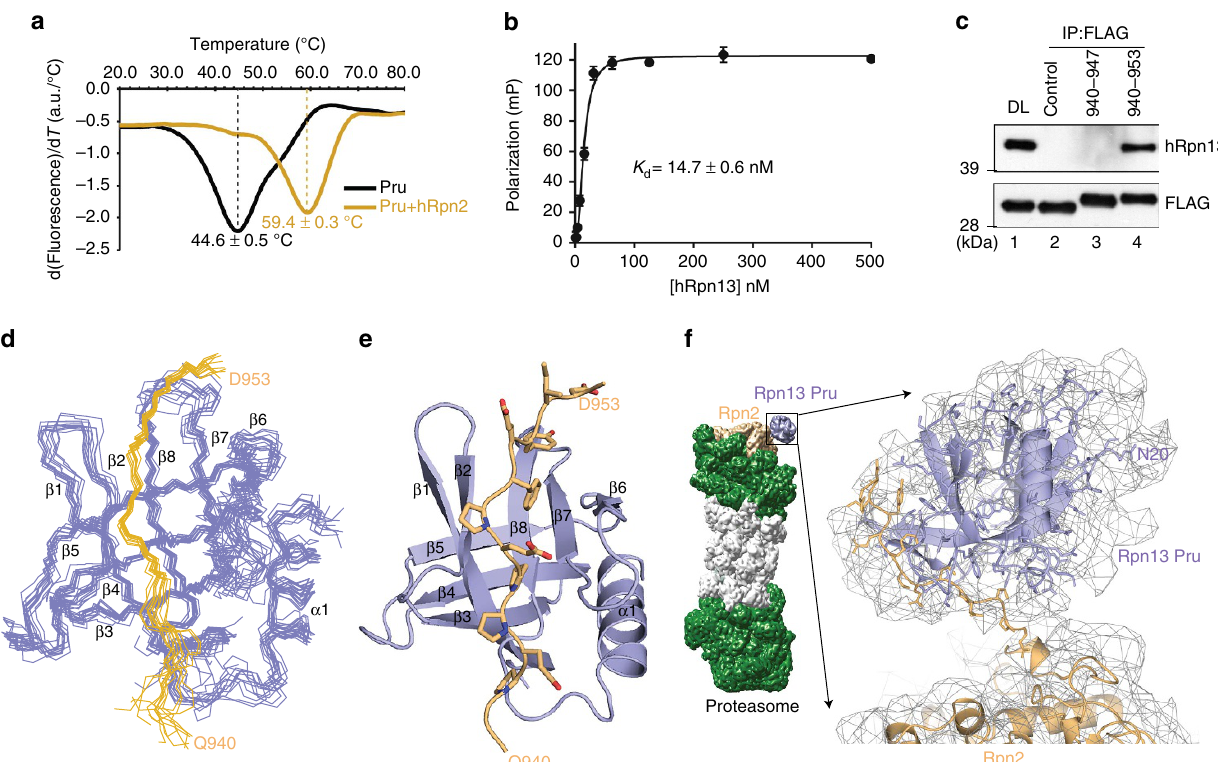
Figure 1 | Structure of hRpn13 at the proteasome. ( a ) hRpn13 Pru alone (black) or with hRpn2 (940–953) (orange) was heated from 20 to 85 (cid:2) C at a rate of 1 (cid:2) C per min. The melting temperature was calculated from the first derivative of tryptophan emission intensities at 350nm (a.u., arbitrary unit). ( b ) 10nM FITC-labelled hRpn2 (940–953) was incubated with varying concentrations of full-length hRpn13 as indicated in triplicate to measure a binding constant by FP. Corresponding values for the probe alone were subtracted from measurements of the complex and the final numbers plotted against hRpn13 concentration and fit by nonlinear regression to a Hill slope model. The error bar represents the s.d. of each data point to the average value. ( c ) Cell lysates or immunoprecipitates derived by anti-FLAG antibodies from HCT116 cells expressing FLAG-EGFP (control), FLAG-EGFP-hRpn2 (940–947) or FLAG-EGFP-hRpn2 (940–953) were subjected to immunoprobing, as indicated. Direct loading (DL) of the lysates from FLAG-EGFP-expressing HCT116 cells is also included. ( d ) Backbone heavy atoms for the 12 lowest energy structures with best geometry for the hRpn13 Pru-hRpn2 (940–953) complex with hRpn13 displayed in periwinkle blue and hRpn2 in light orange. ( e ) Ribbon diagram for the hRpn13 Pru-hRpn2 (940–953) structure depicting the classic pleckstrin homology fold of hRpn13 Pru (periwinkle blue) with the hRpn2 peptide (light orange) extended across a b -strand surface. hRpn2 nitrogen and oxygen atoms are displayed in blue and red, respectively. ( f ) The hRpn13 Pru-hRpn2 (940–953) structure is modelled into a cryoEM reconstruction (EMD-2594, displayed in grey) from S. cerevisiae 26S proteasome 50 that includes the scRpn2 PC repeat region (PDB code 4CR2). The N-terminal 19 amino acids of hRpn13 Pru are randomly coiled and most likely contribute to the extra density displayed near residue